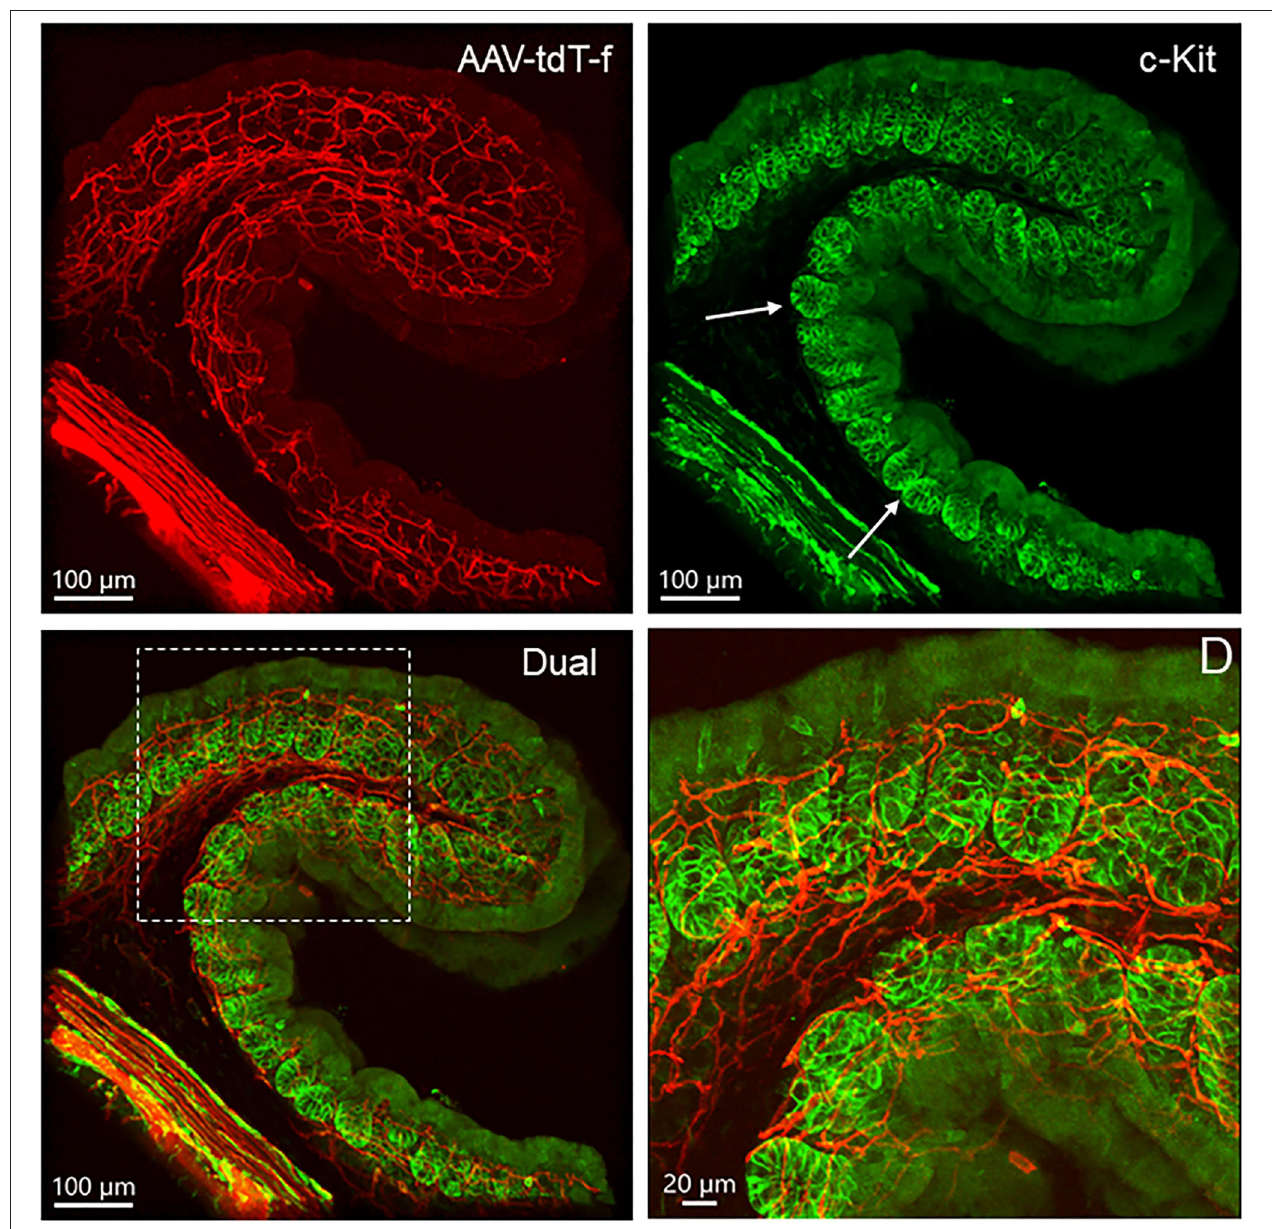
FIGURE 14 | Dual labeling of PHP.S-tdTf (red) and c-Kit (green) show locations of c-Kit-immunoreactive cells in relationship with nerve fibers in transverse sections of the mouse proximal colon. Cells in the mucosa crypt base contained c-Kit immunoreactivity as indicated by arrows, and the area in the dash line is magnified in D.